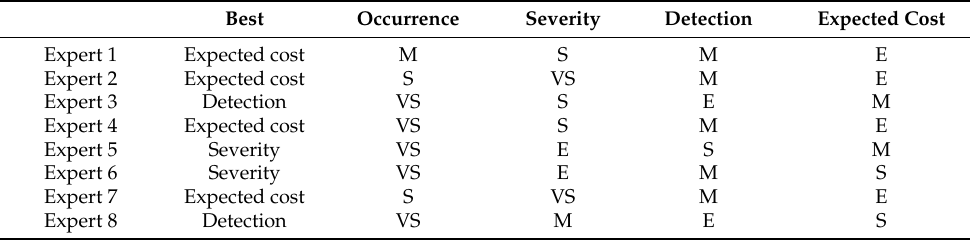
Table 5. Importance of the best criterion over all the criteria.